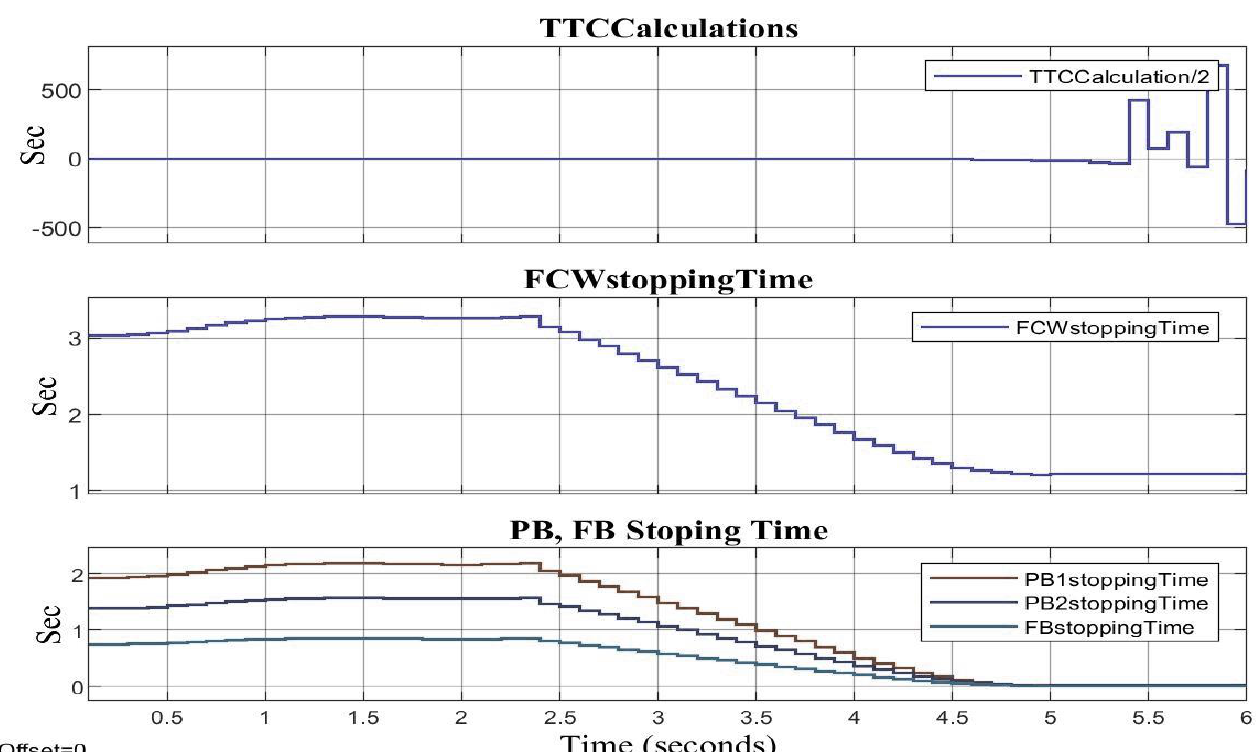
Figure 20. The behavior of time-to-collision and the stopping times for FCW, first stage partial, second stage partial, and full brake.